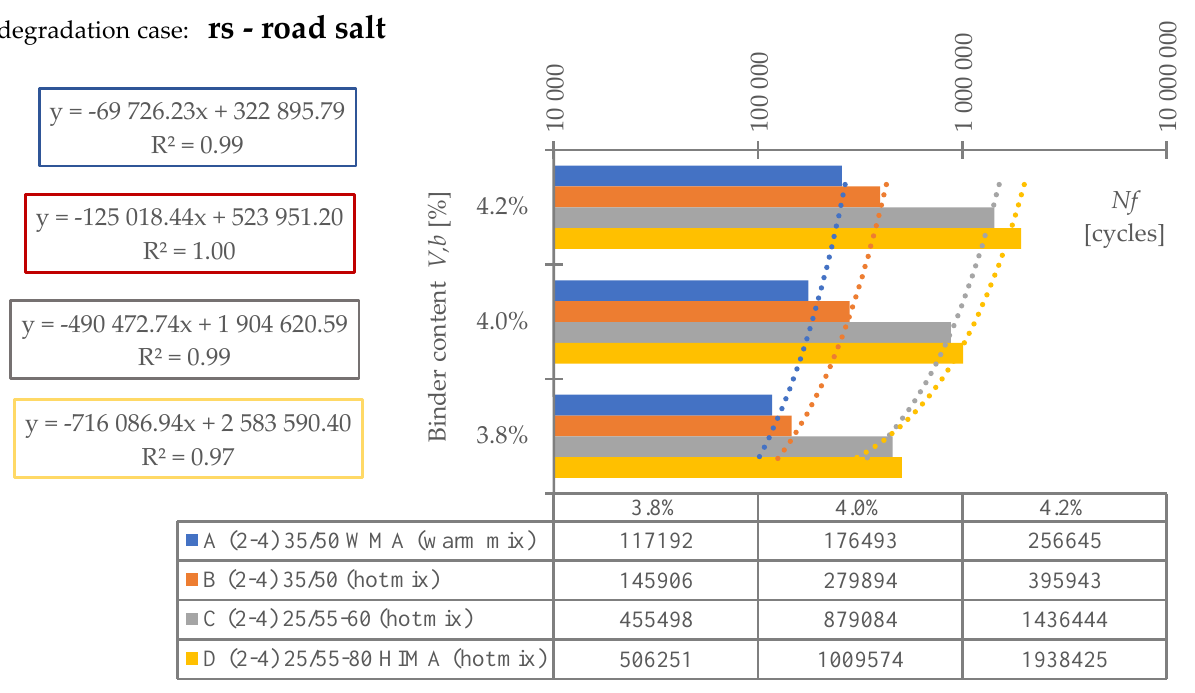
Figure 12. Fatigue test results — road salt impact.